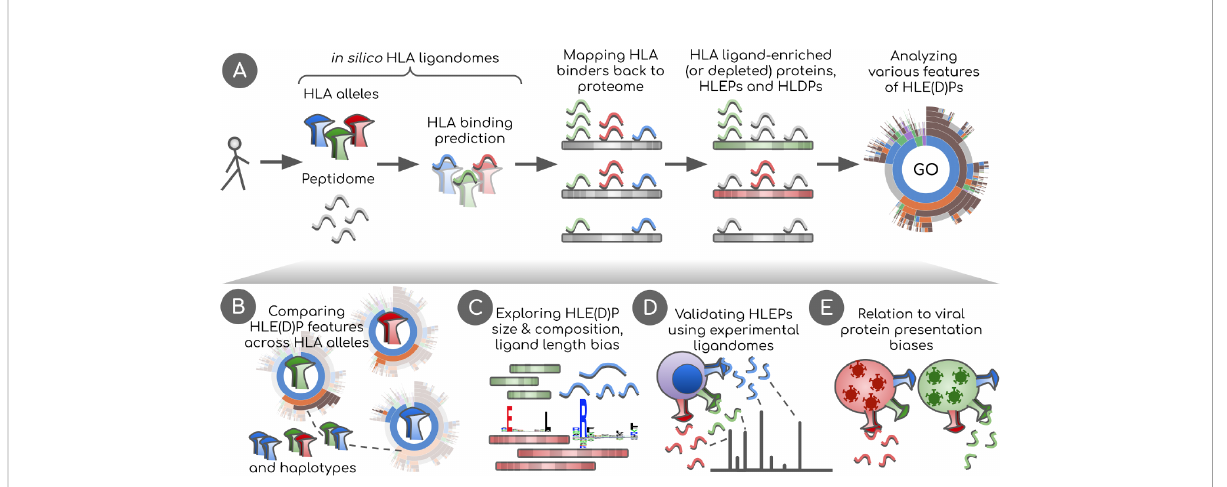
FIGURE 1 Overview of the study. (A) In silico HLA ligandomes are generated by running HLA binding prediction software for the human peptidome (8- to 12-mers). HLA binders are then mapped back onto their parent proteins. Statistical analysis is performed to de fi ne sets of human proteins enriched or depleted in HLA ligands, HLEPs and HLDPs respectively. Functional analysis of these gene sets is performed using Gene Ontology (GO) category enrichment tests. (B) GO annotation results are used to perform comparative analyses of HLA alleles, de fi ning characteristic features of HLE(D)Ps. We show that preferred GO categories are clearly distinct between HLA alleles de fi ning groups alleles with speci fi c GO annotation pro fi les. These differences are however balanced and compensated by non-random selection of HLAs in HLA haplotypes observed in the population. (C) Potential biases that shape HLE(D)P sets are explored, such as protein length, protein amino acid composition, together with the length of HLA ligands and HLA anchor residue types. (D) Results are validated using real HLA ligandomes obtained from mass spectrometry data. (E) Differences are identi fi ed in non-self peptide presentation by various HLAs by studying HLA presentation preferences of viral proteins. We link viral and human peptide presentation by demonstrating the relation between self- and non-self protein presentation preferences for various